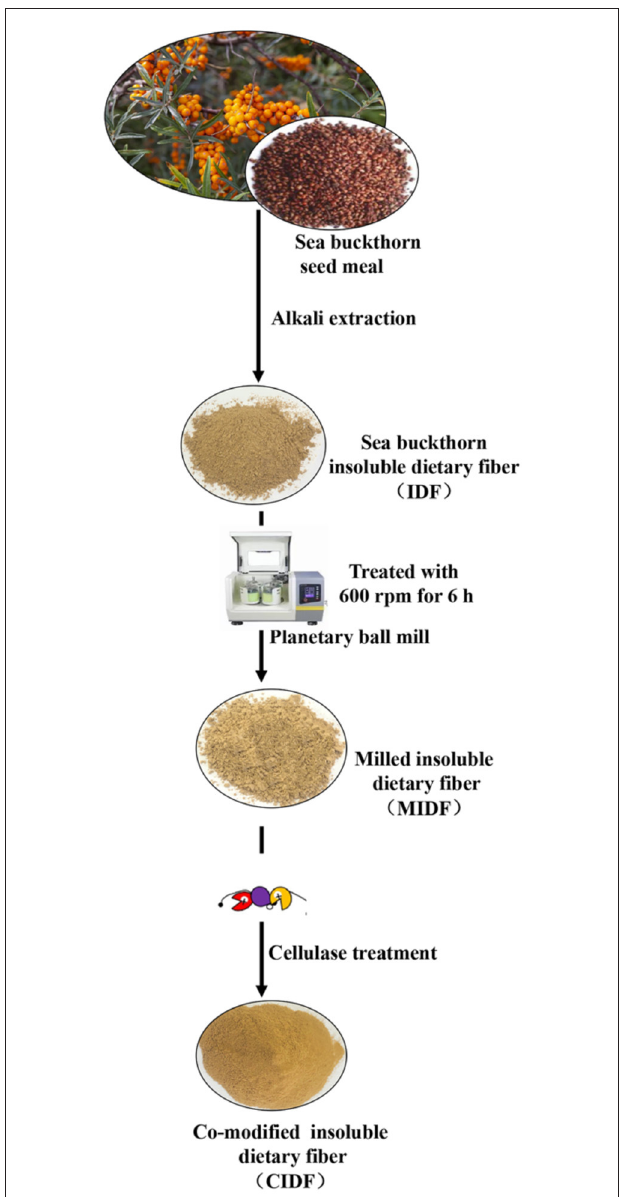
FIGURE 1 | The flowchart of the preparation of MIDF and CIDF.